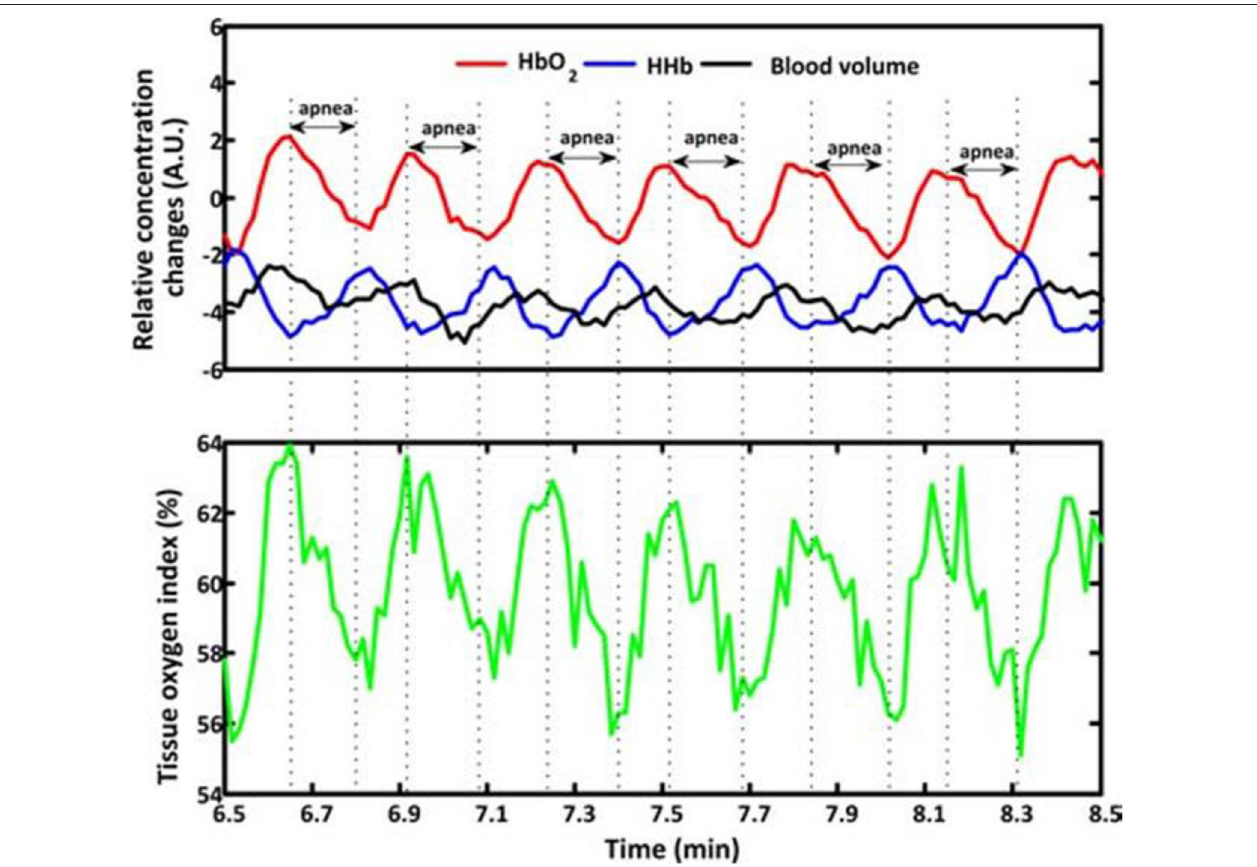
FIGURE 4 | Typical fragments of cerebral hemodynamics during baseline measurements measured from Subject 1. The apnea events are marked by dash lines and double arrows. BV, HbO 2 and HHb changes are expressed in arbitrary units (A.U.), as the mean value of first 60-s measurements was set at 0. During apnea events, the BV, HbO 2 and tissue oxygen index signals show parallel decrease that are opposite to the HHb which increases after the initiation of apnea. Then an increase of BV, HbO 2 and tissue oxygen index, while a decrease of HHb appears after the termination of apnea. An example of the changes of NIRS indices in response to apnea adapted from Zhang et al. (